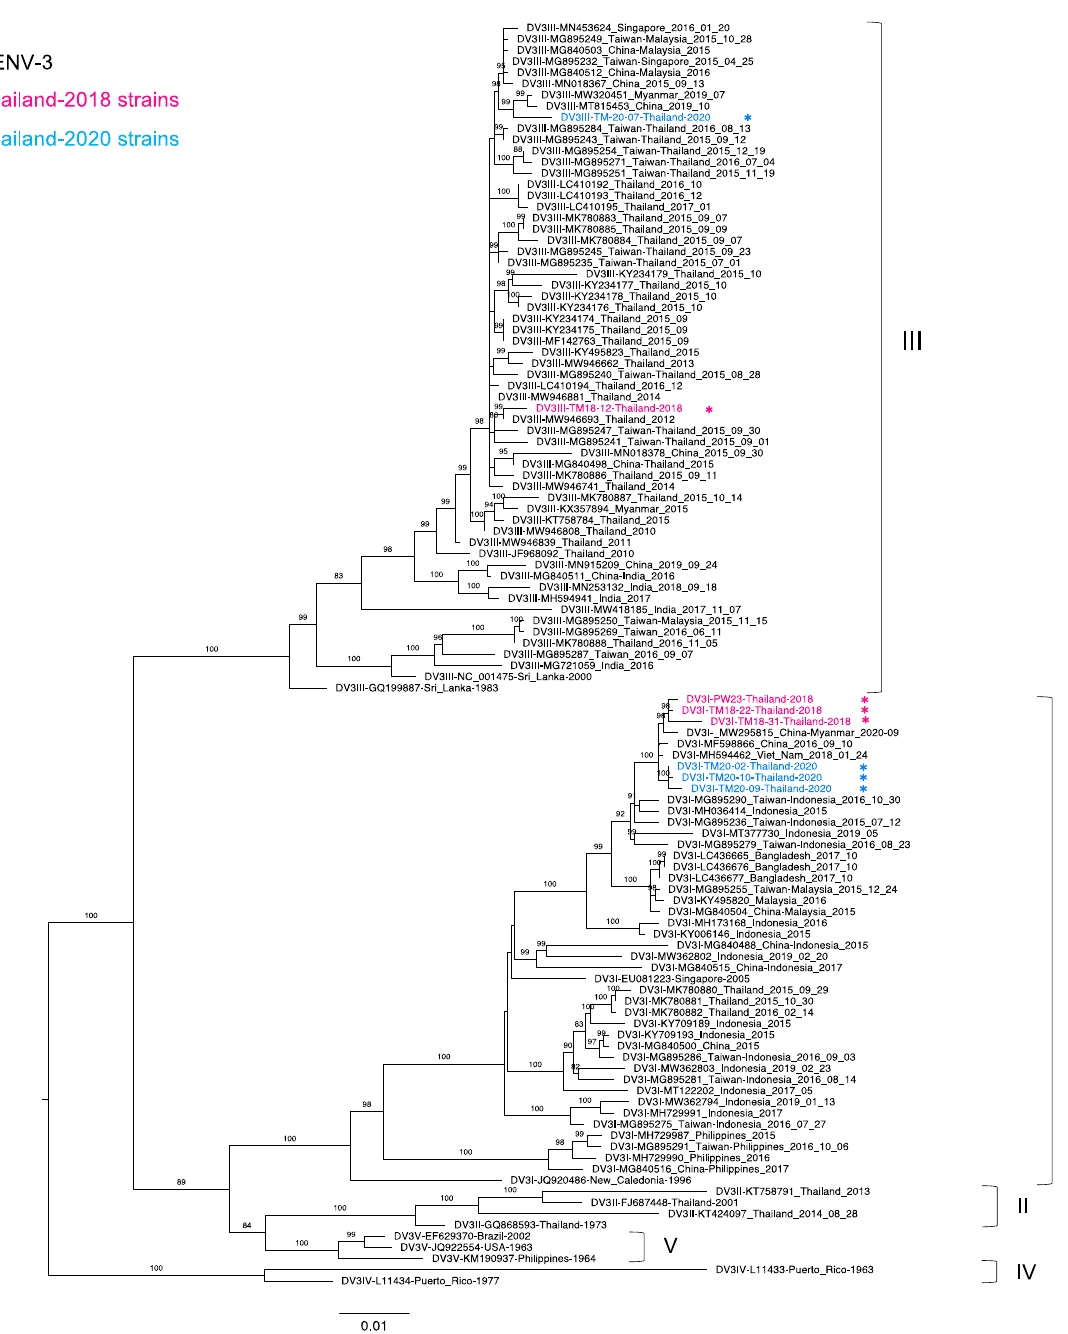
Figure 3. Phylogenetic analysis of Thailand DENV-3 in 2015–2020. The maximum-likelihood (ML) tree was constructed based on the complete envelope (E) region sequences (1479 nucleotides) under TN + F + I + G4 with 1000 ultrafast bootstrap replicates. The ML tree included eight newly determined sequences of DENV-3 from clinical specimens in Bangkok in 2018–2020, their related strains, Thailand strains during 2015–2020, and the reference genotypes. The sequences collected in 2018 and 2020 are labeled in pink and blue, respectively, and indicated in the upper left corner. Viral genotypes are indicated by black brackets on the right. The sequences newly determined in the present study are marked with asterisks (*). Sequences are shown by serotype, accession number, country, and reported year. Numbers on branches are bootstrap support values exceeding 80%.